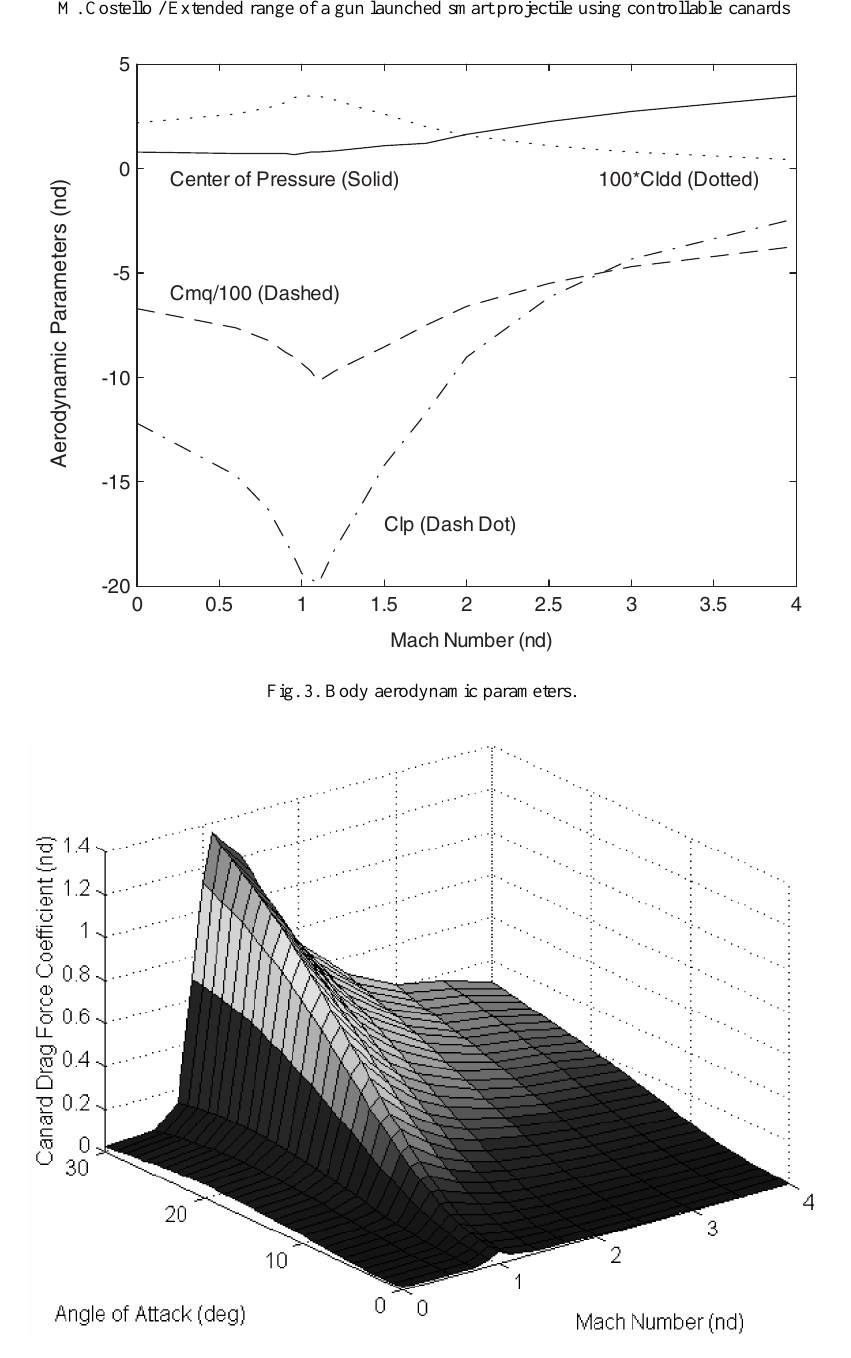
Fig. 4. Canard drag force coefficient